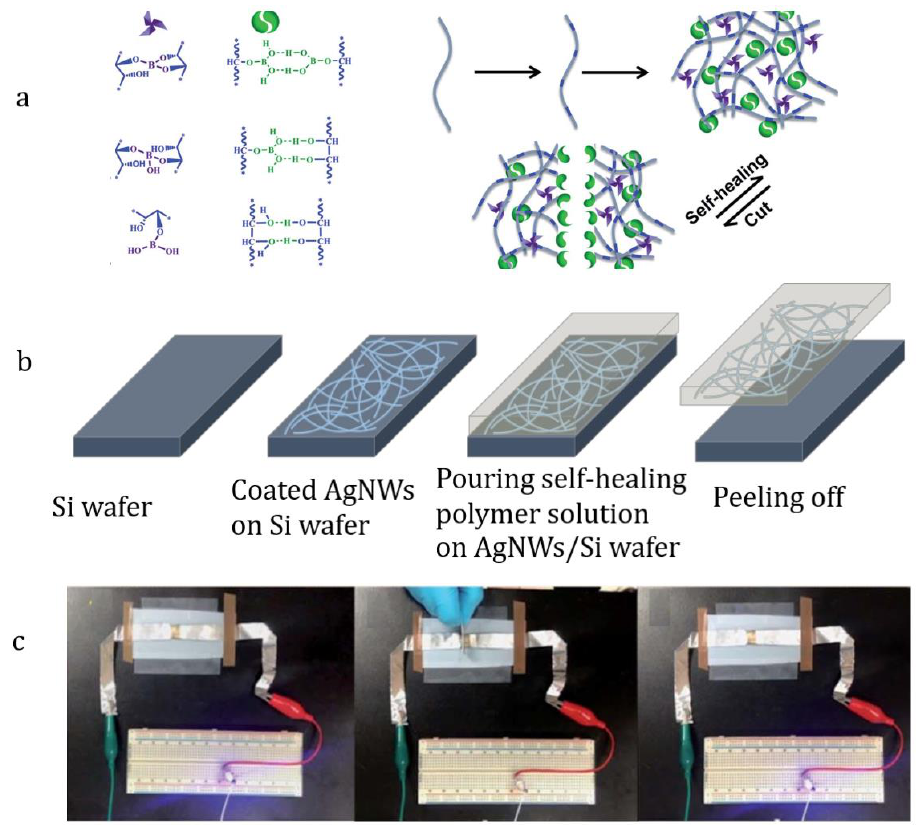
Figure 13. Scheme of PDMS- block -dithiothreitol preparation ( a ), flexible self-healing Ag NWs/PDMS- block -dithiothreitol electrode fabrication ( b ), and optical image of working electrode ( c ). Reproduced with permission [76]. Copyright 2022, Royal Society of Chemistry.